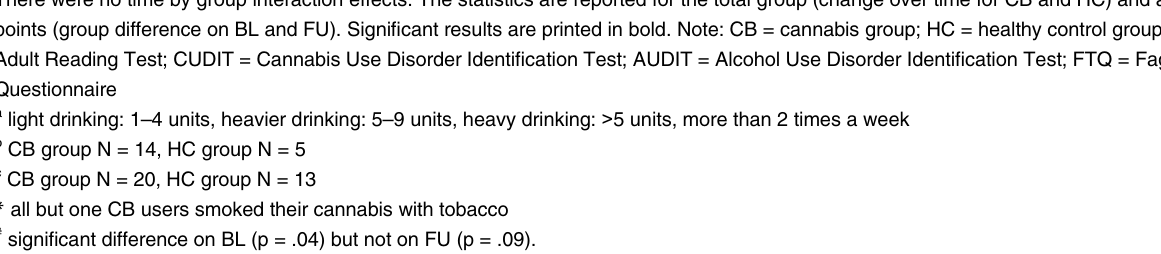
There were no time by group interaction effects. The statistics are reported for the total group (change over time for CB and HC) and a total for both time points (group difference on BL and FU). Signi fi cant results are printed in bold. Note: CB = cannabis group; HC = healthy control group; DART =